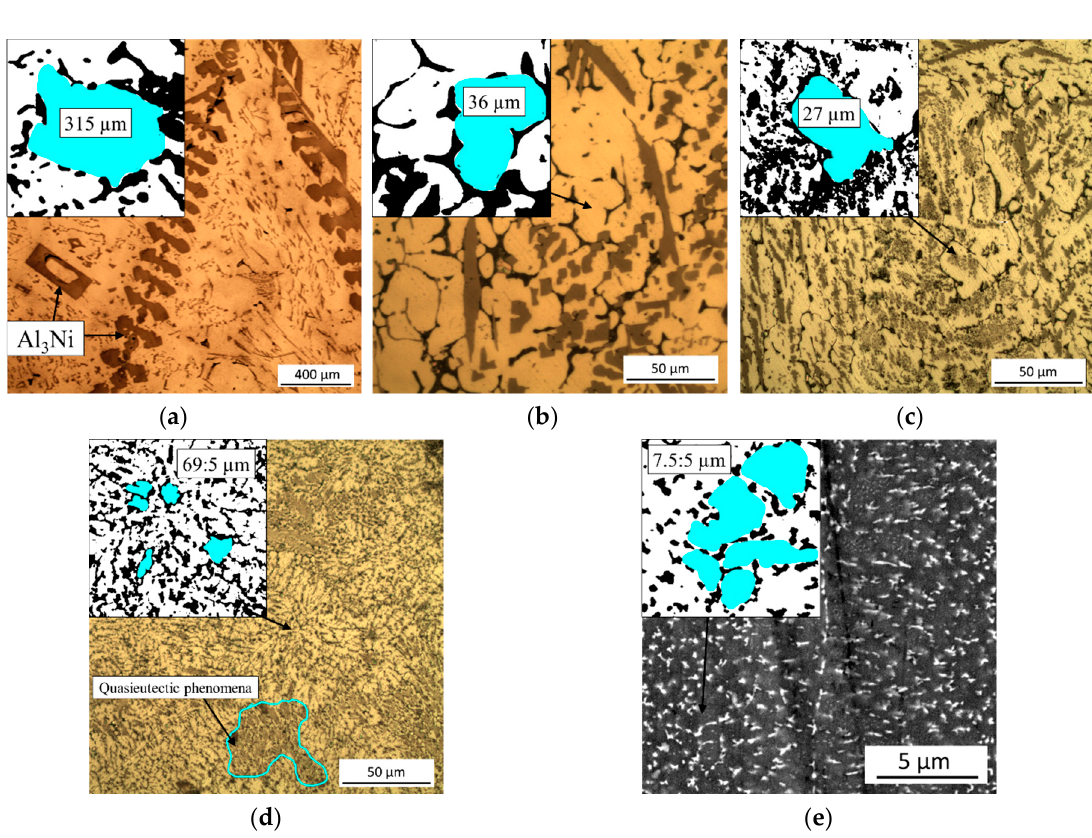
Figure 4. Microstructures of the Al8Zn7Ni3Mg alloy after solidification at different cooling rates, including binary imaging used for dendritic parameter determination: ( a ) furnace-cooled (FC) sample; ( b ) 30 mm cast sample; ( c ) 5 mm cast sample; ( d ) 1 mm cast sample; ( e ) melt spinning (MS) sample .